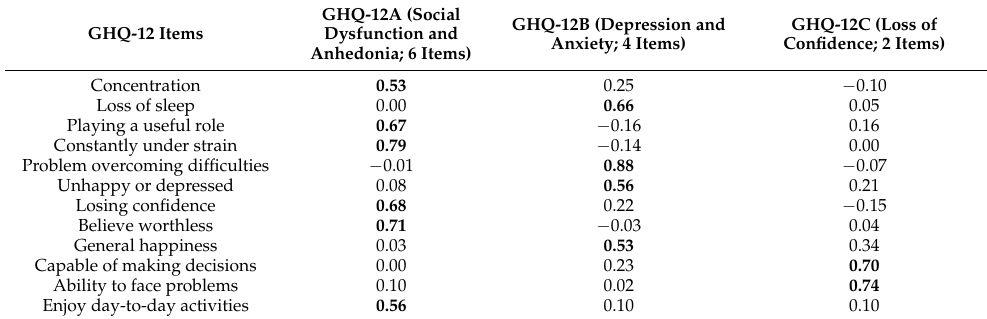
Table 2. The factor loadings for the three-factor structure of the GHQ-12.